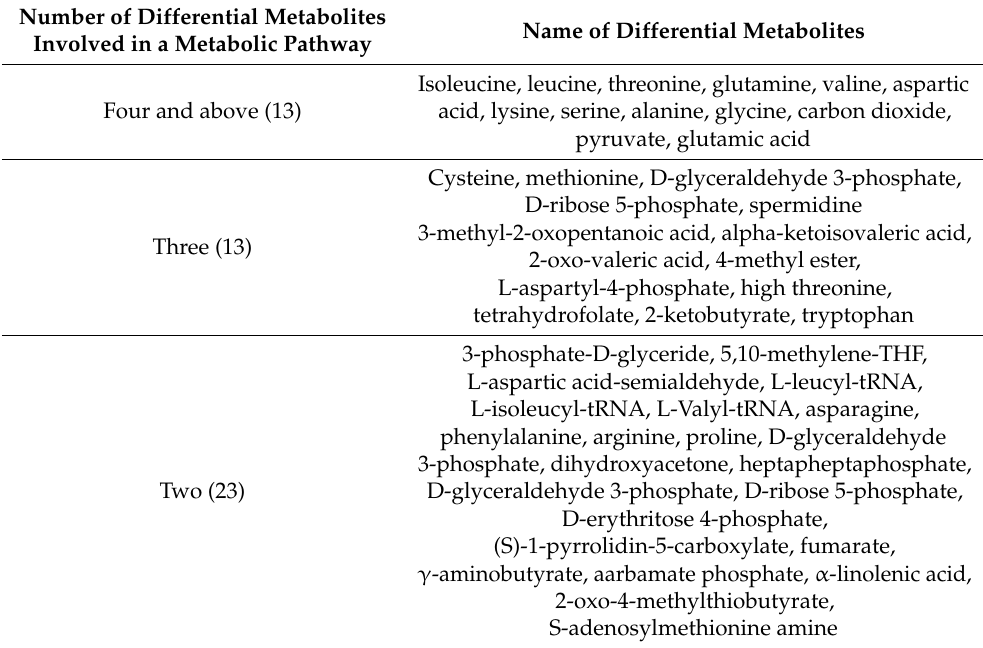
Figure 5. Factors affecting metabolic pathways. Table 5. Details of the differential metabolites and metabolic Table 4. List of factors affecting metabolic pathways.